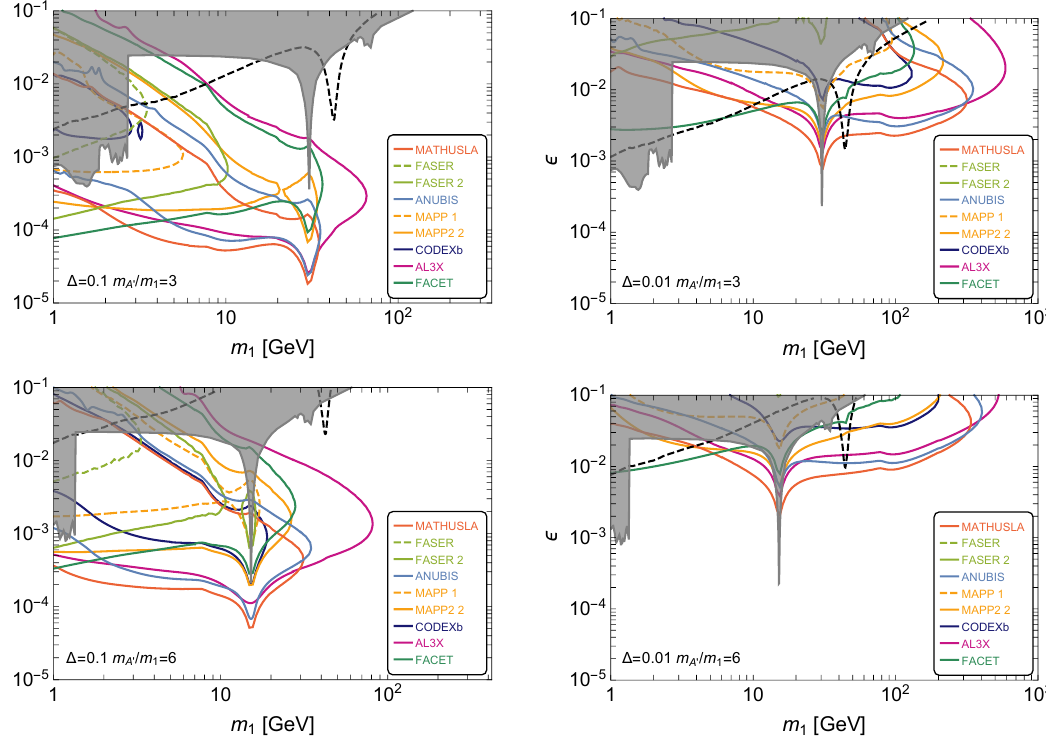
Figure 1 . Projected sensitivities of proposed future experiments (coloured lines) and existing constraints (grey regions) on the model of fermionic iDM described in section 2.1 in the m 1 − (cid:15) plane for ∆ = { 0 . 1 , 0 . 01 } and m A 0 /m 1 = { 3 , 6 } . The dashed black contour depicts where the abundance of the χ 1 matches the observed dark matter energy